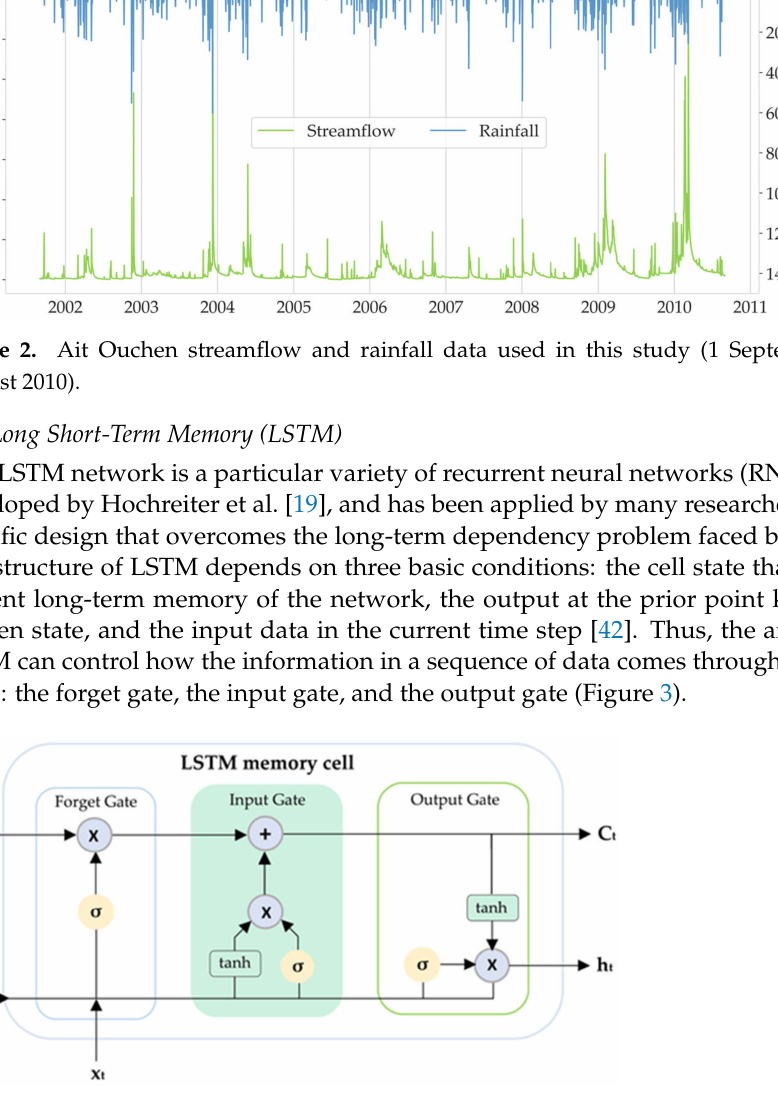
Figure 3. The architecture of Long-Short-Term Memory (LSTM) where σ presents the sigmoid function, tanh the hyperbolic tangent, C t − 1 previous cell state, h t − 1 previous hidden state, x t input data, C t new cell state and h t present the new hidden state. The adding and scaling of information is represented by the vector operations (+) and (X),